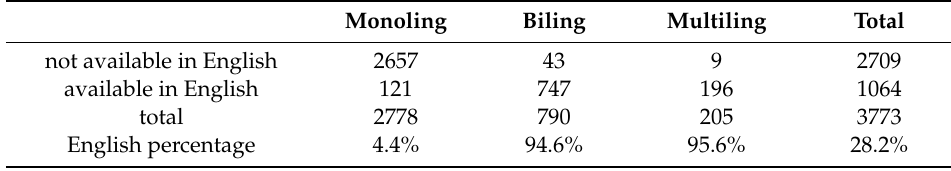
Table A34. English language availability (lt).